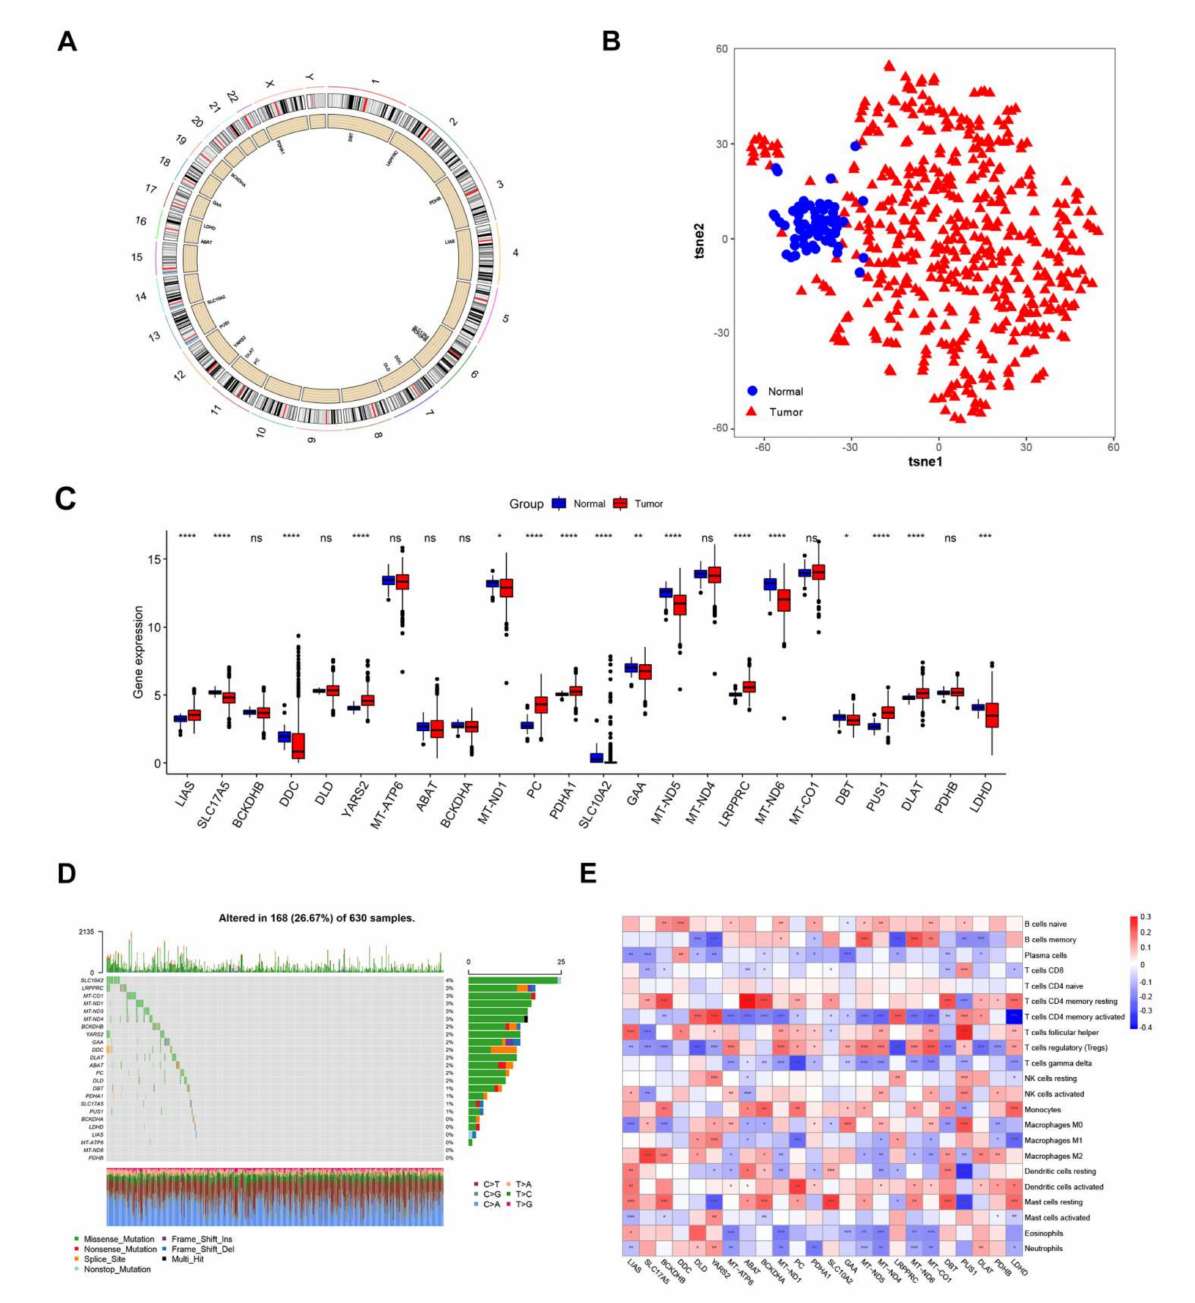
Figure 1. Genetic variation and immune infiltration of lactate metabolism-associated gene in LUAD. ( A ) The specific distribution of lactate metabolism-associated genes on chromatin demonstrated by the Circos package of R. ( B ) PCA analysis combined with TSNE verified lactate metabolism-associated genes had the ability to distinguish normal sample from tumor ones. ( C ) Most lactate metabolism- associated genes were differently expressed between the tumor and normal samples. A Wilcox test was used to compare the statistical difference between the normal and tumor samples ( p < 0.05). ( D ) The mutation rate and kinds of lactate metabolism-associated genes in LUAD. ( E ) The CNV of lactate metabolism-associated genes in LUAD. The lactate metabolism-associated gene expression correlated with immune cell infiltration in LUAD, the proportion of immune cells and the correlation with each lactate gene expression was calculated by CIBERSORT ( p < 0.05). * p < 0.05, ** p <